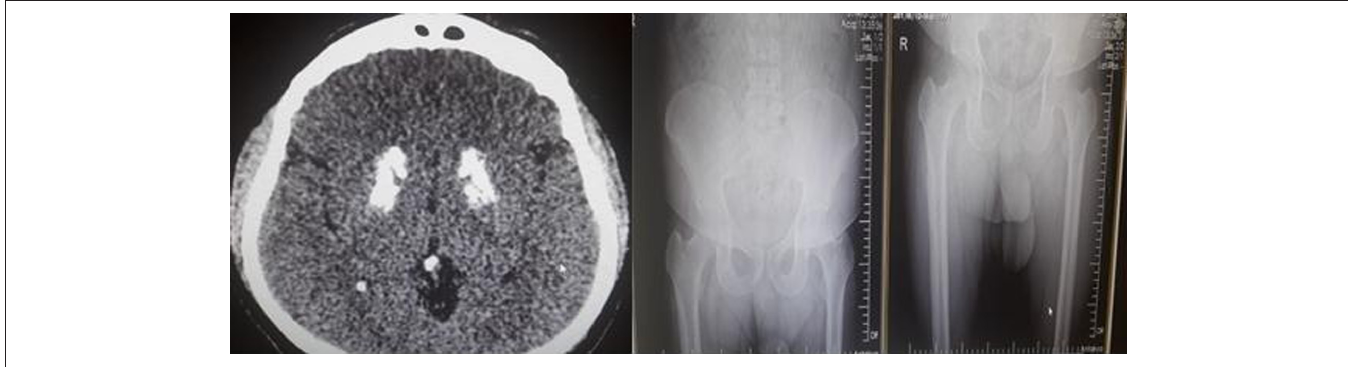
Figure 1. Intracerebral calcifications on computed tomography and diffuse osteosclerosis on long bone